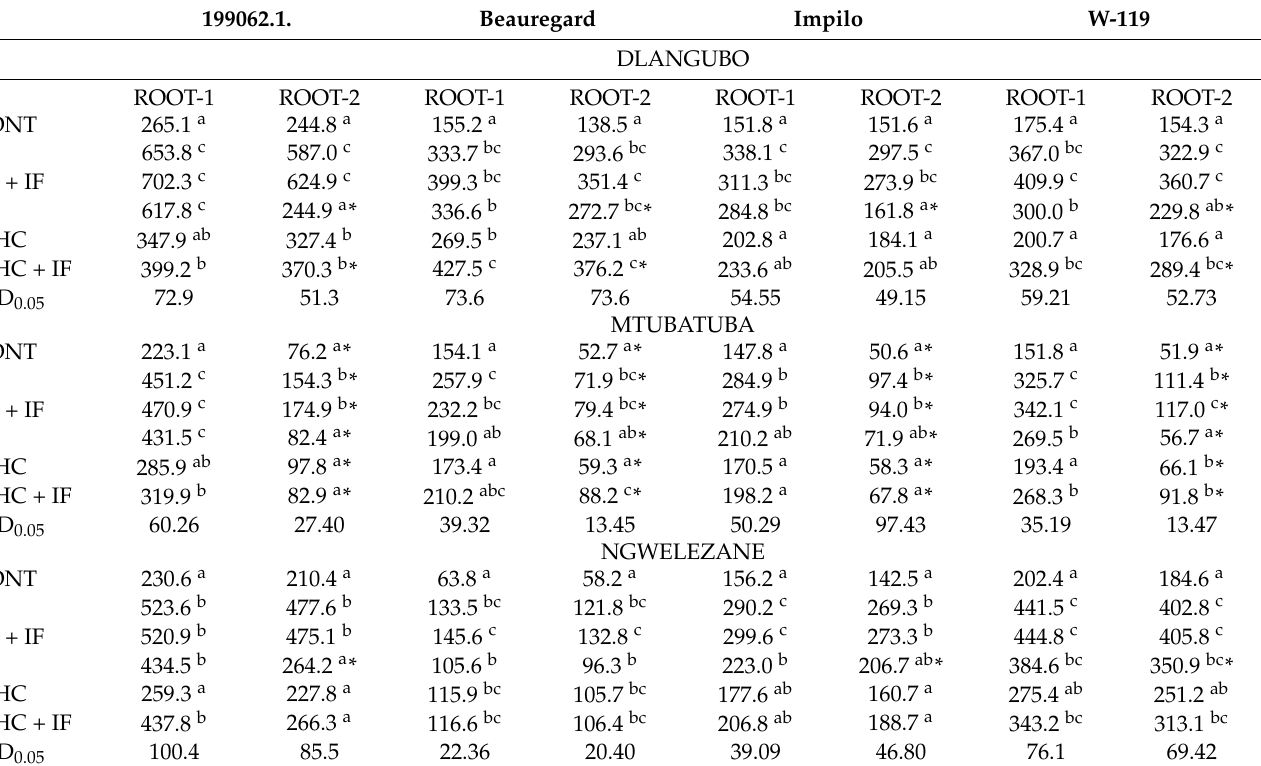
Table 3. Effects of filter cake, a combination of filter cake and inorganic fertilizer, inorganic fertilizer, macadamia compost, a combination of macadamia husk compost, and control treatments on the storage roots of four orange-fleshed sweet potato cultivars grown at the Dlangubo, Ngwelezane,